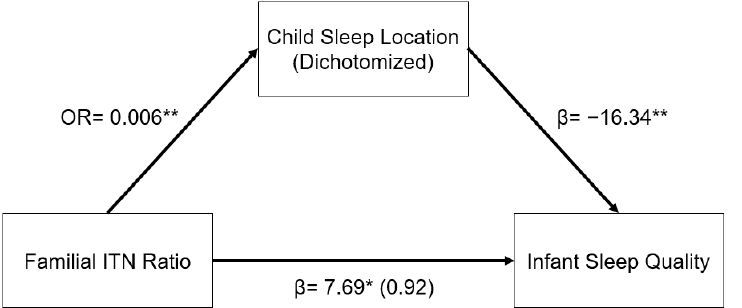
Figure 1. Regression coefficients or odds ratio for the relationship between familial income-to-needs (ITN) ratio and infant sleep quality (mISS) as mediated by child sleep location (1 = room with parents). Child sleep location is a significant indirect mediator of the link between familial ITN and infant sleep quality. The regression coefficient between familial ITN ratios and mISS, controlling for child sleep location, is in parentheses. ** p < 0.01, * p < 0.05.